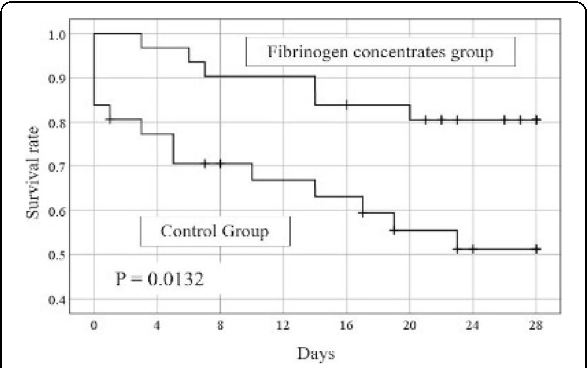
Fig. 1 (abstract 000276). See text for